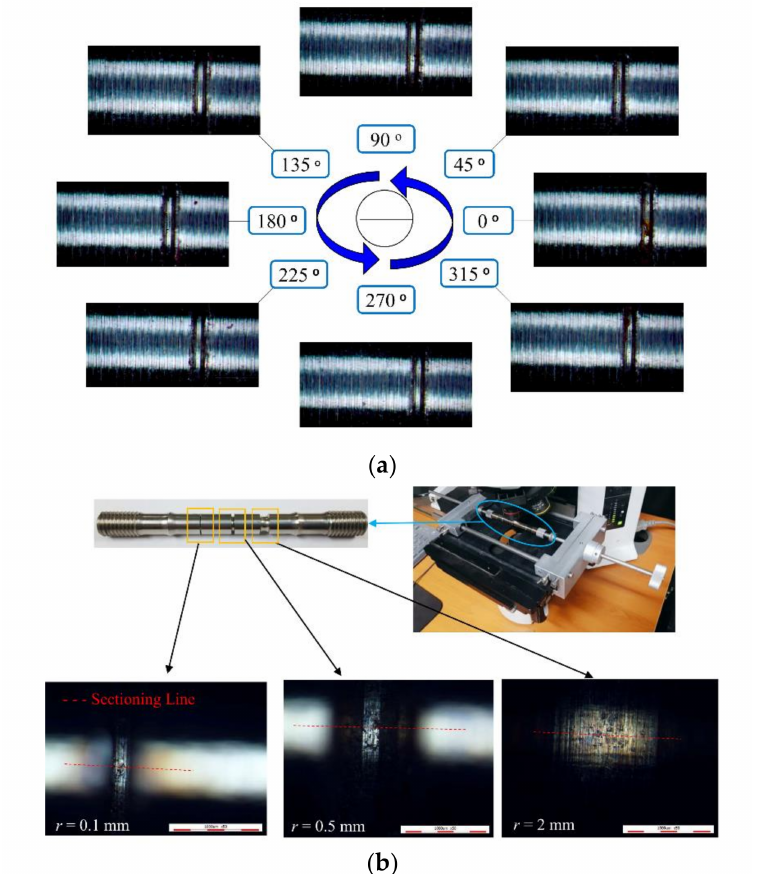
Figure 4. Analysis of the corrosive surface using OM. ( a ) Captured surface by rotating the notched bar specimen and ( b ) sectioning line at the most corroded